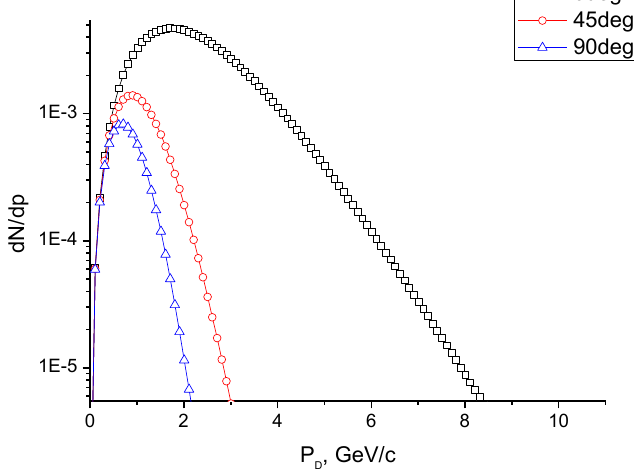
Figure 4. dN/dp for D+D- production as a function of D meson momentum in Au-Au collisions at 4 GeV/c ( √𝑆 =9.875 GeV) for 0, 45, and